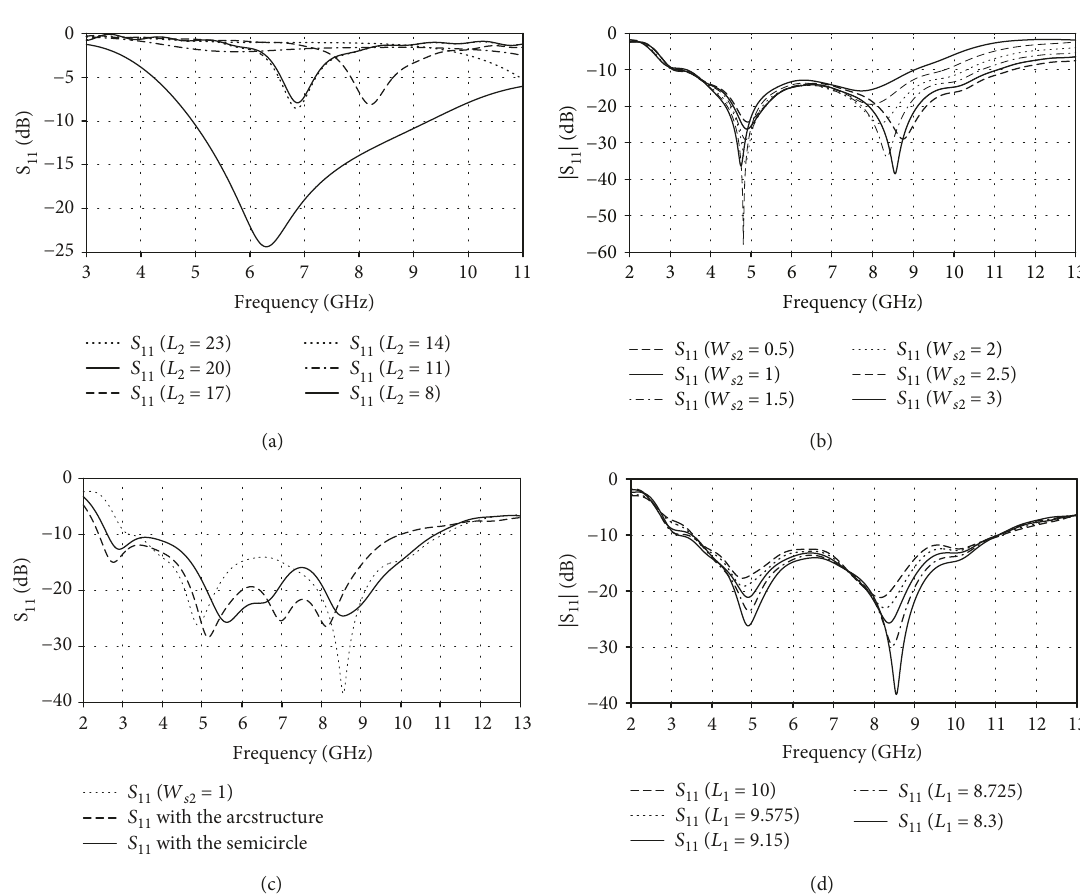
Figure 2: (a) Con fi guration of antenna 1. (b) Con fi guration of antenna 2. (c) Con fi guration of antenna 3.